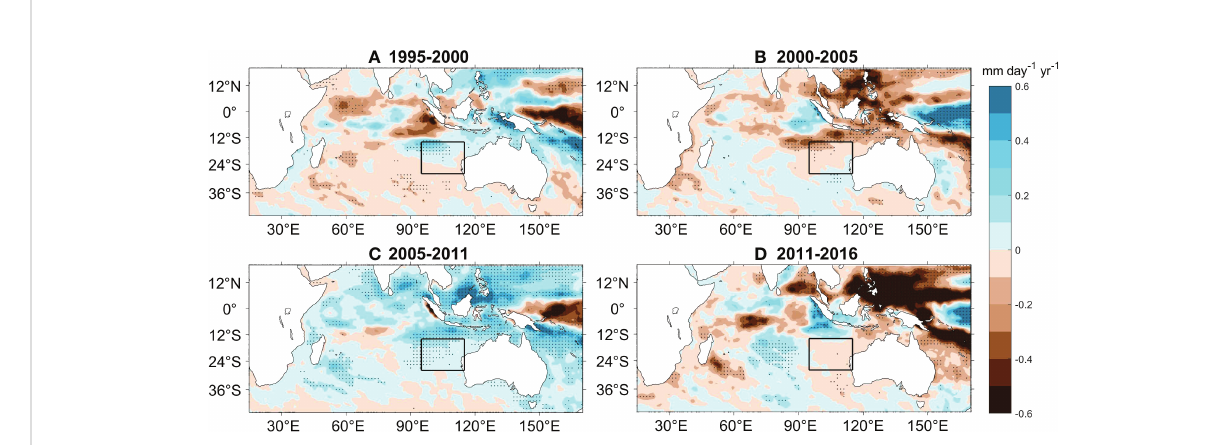
FIGURE 7 Linear trends of surface precipitation (mm day -1 year -1 ) for the periods of (A) 1995-2000, (B) 2000-2005, (C) 2005-2011, and (D) 2011-2016 derived from ERA-Interim. Stippling indicates signi fi cant trends at 90% con fi dence level based on a Mann-Kendall test. Black lines denote the